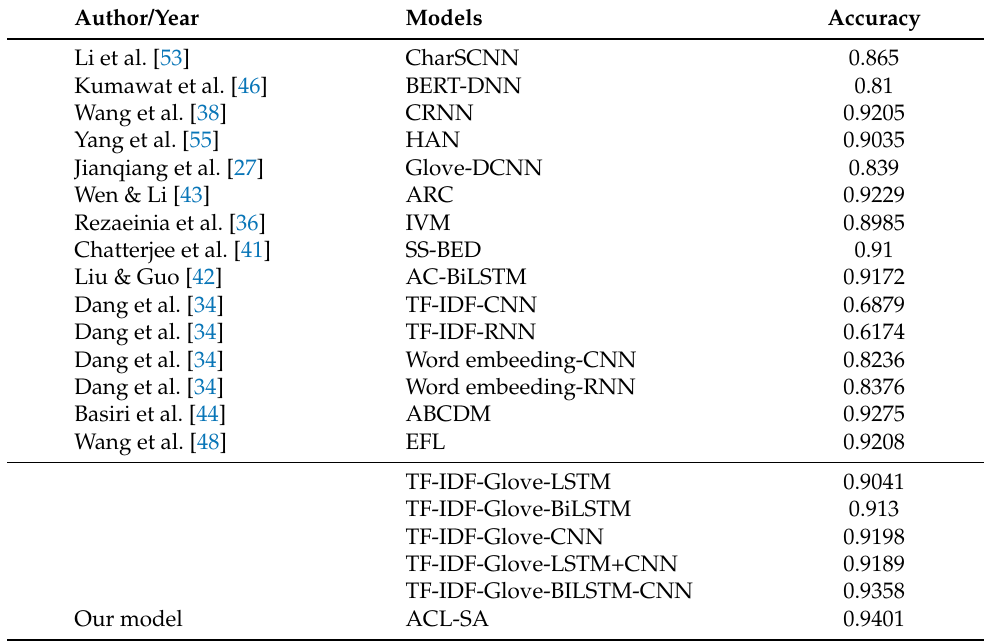
Table 4. US-Airline Twitter dataset accuracy compression with baseline models.